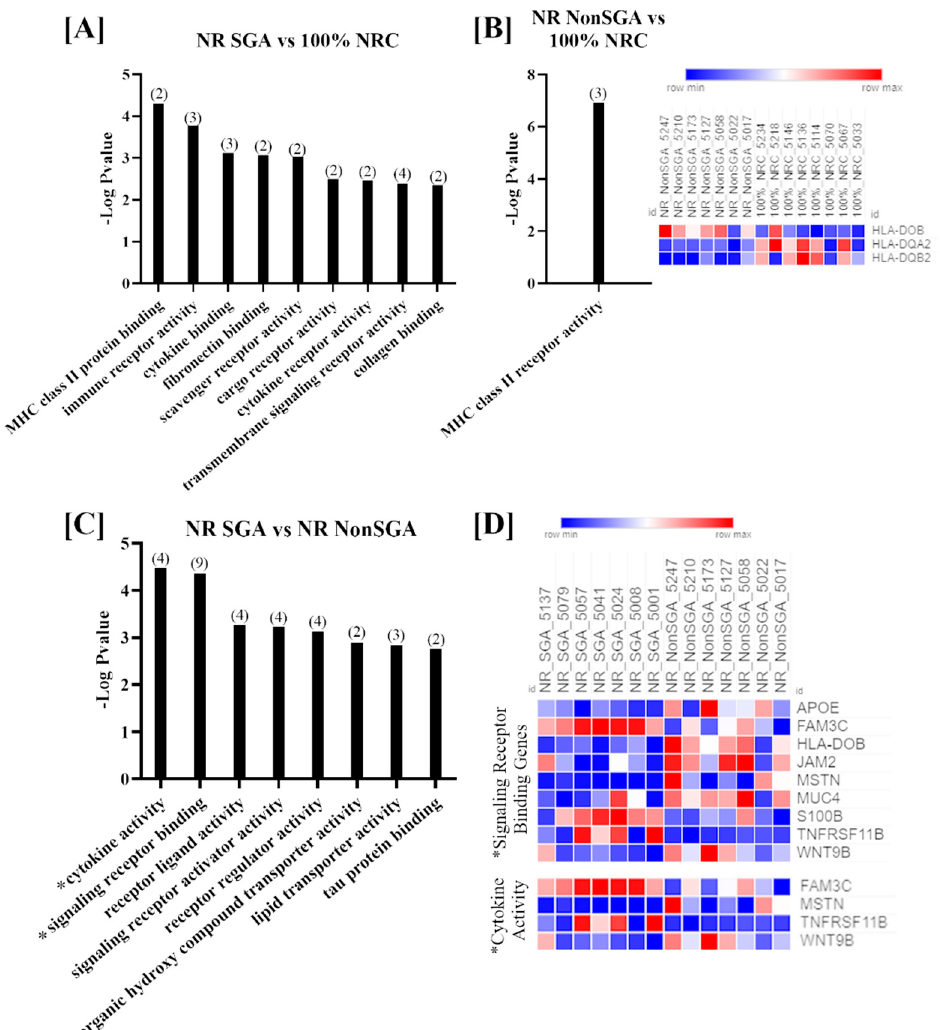
Figure 2. GO molecular function analyses of differentially expressed genes (DEGs) in placentomes at day 70 of pregnancy. Molecular functions differentially regulated in NR SGA compared to 100% NRC placentomes ( A ). The molecular function differentially regulated in NR NonSGA compared to 100% NRC placentomes, with a heat map of the three involved genes ( B ). Molecular functions differentially regulated in NR SGA compared to NR NonSGA placentomes ( C ), with a heat map of genes involved in “signaling receptor binding” and “cytokine activity” ( D ). The heat maps correspond to one sample for each column and one gene for each row. All depicted GO molecular functions were significant at FDR < 0.05. Numbers in parentheses indicate the number of DEGs involved in the function.